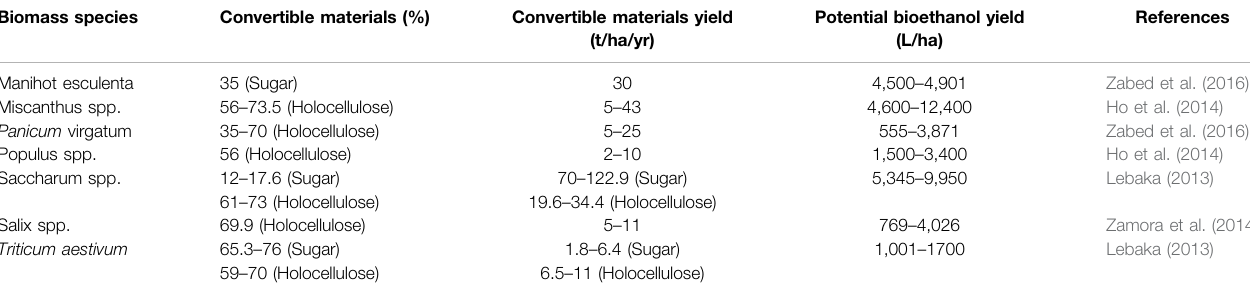
TABLE 3 | Potential of different types of forest biomass for second-generation bioethanol production. Biomass